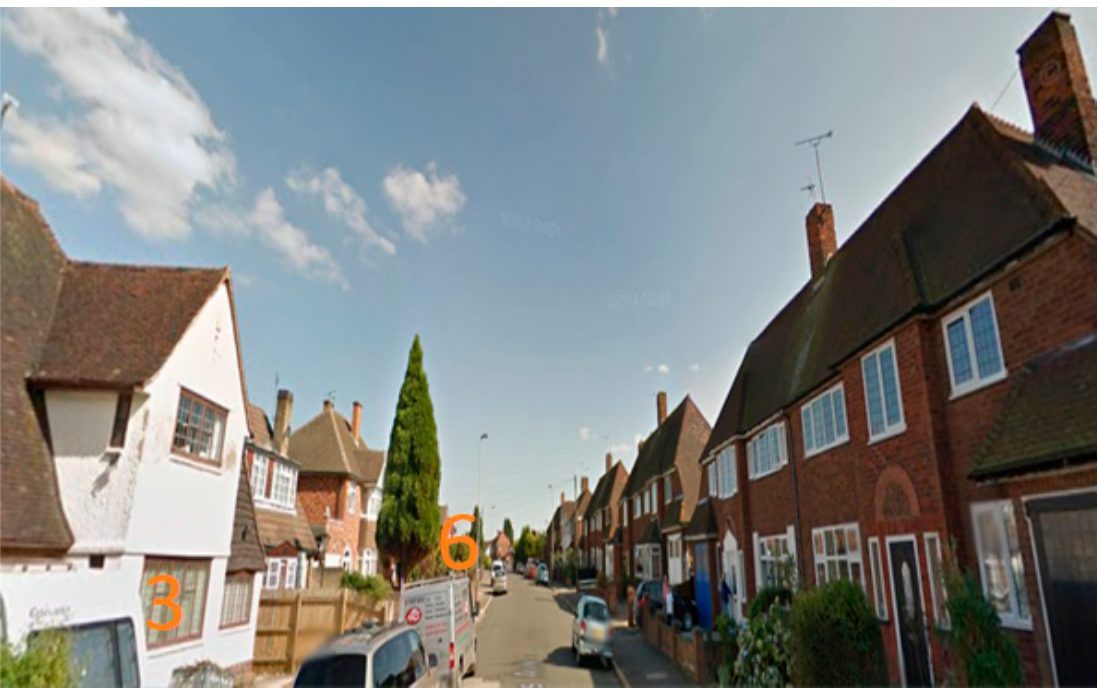
Figure A4. Location 4 (Map data ©2017 Google).